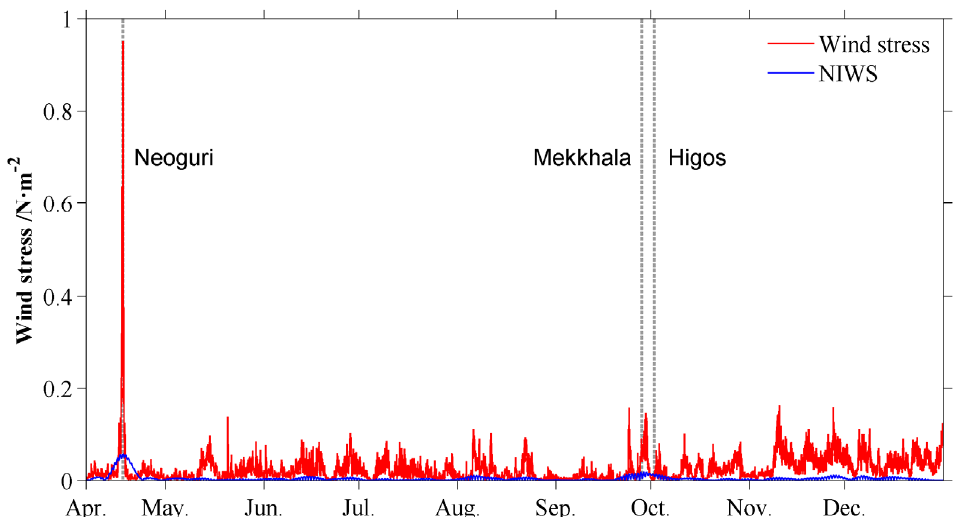
Figure 2. Time series of the hourly wind stress (red line, unit in N / m 2 ) and near-inertial wind stress (NIWS, blue line) at the meteorological observation station from 6 April to 31 December in 2008. Vertical dashed lines denote the arrival of typhoons.